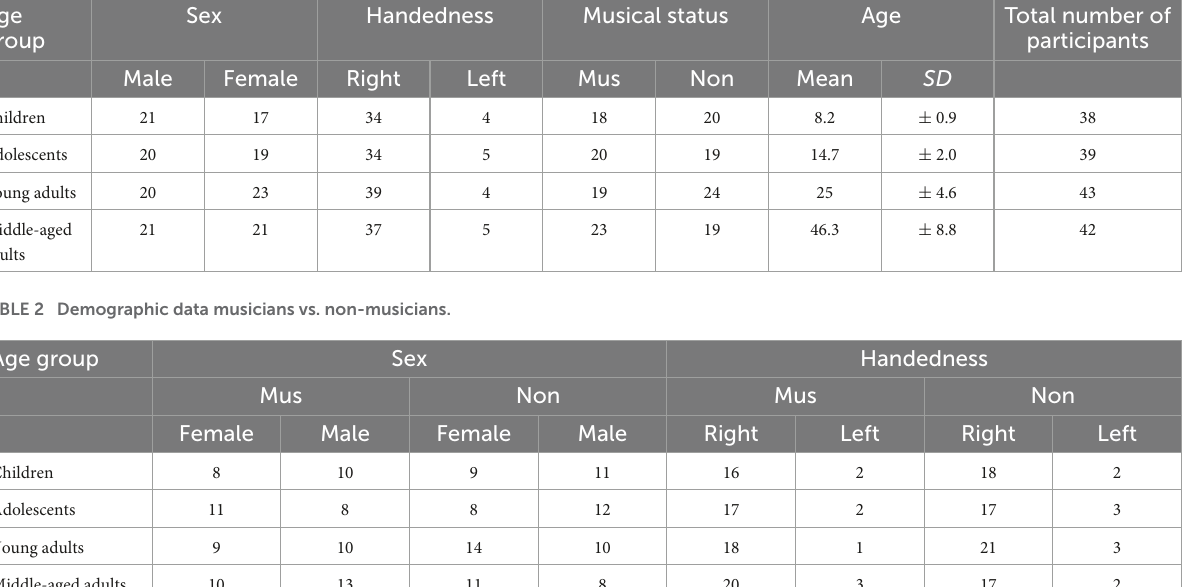
TABLE 1 Demographic data age groups.